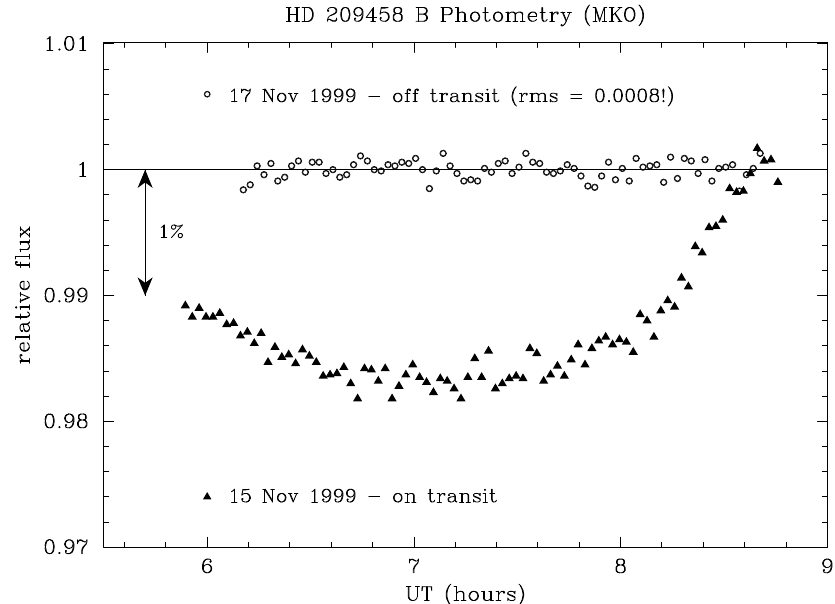
Fig. 5. instrumental magnitude versus airmass plots for the comparison star on 15 and 17 November